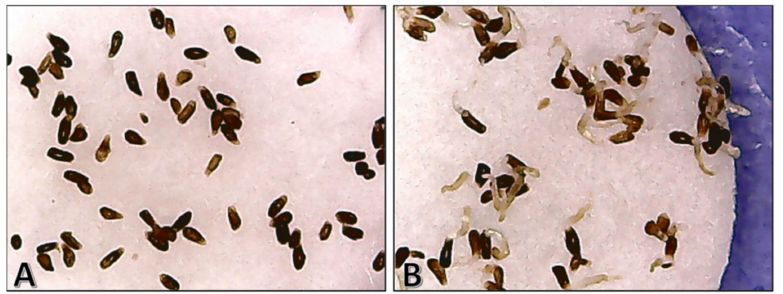
Figure 5. Photographs of Orobanche cumana seeds after a germination bioassay. ( A ) No germinated seeds, after treatment with an inactive compound; ( B ) almost all germinated seeds after treatment with a high-active